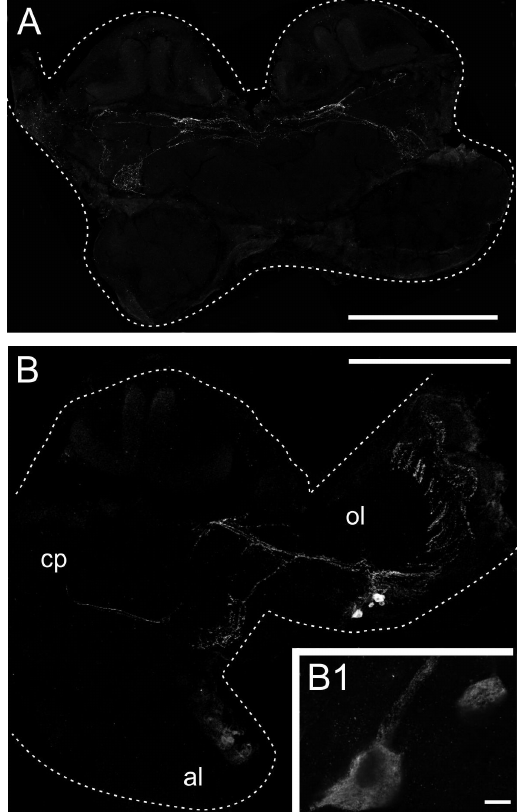
Figure 5. Immunohistochemical analysis of P. americana brain sections with the anti-PeaDOP2-antibody. Cryosections (20 µm) of the brain were labeled with primary antibody (anti-PeaDop2, 1:500). Secondary antibody was Cy2-conjugated goat anti-rabbit IgG (1:100). Images represent projections of image stacks and correspond to 10 µm. The outer margins of the sections are labeled with a stippled line. ( A ) Networks of fibers in the central protocerebrum are labeled in frontal sections of the anterior brain; ( B ) Somata and fibers in the optic lobe (ol) are labeled, in addition to fibers in the central protocerebrum (cp), in frontal sections of the central brain. al, antennal lobe. An enlargement is shown in the inset ( B1 ). Scale bar in ( A ) and ( B ) is 500 µm, scale bar in ( B1 ) is 10